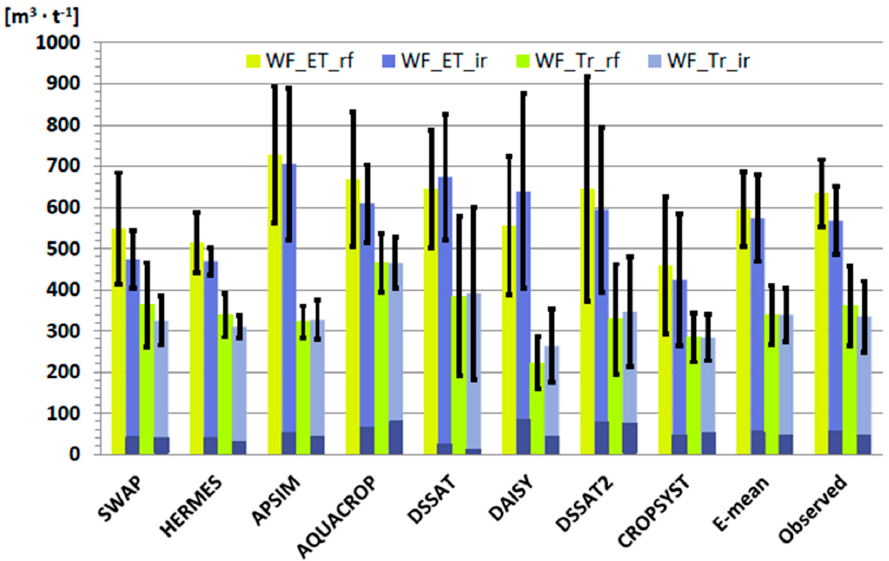
Figure 6. Water footprints of winter wheat calculated from simulations of different models for rainfed (_rf) and irrigated (_ir) variants of the Müncheberg field trial. Calculations were based on ET (WF_ET) and Tr (WF_Tr). Error bars of the model results and observations show inter ‐ annual variability, error bars of the ensemble mean the inter ‐ model variability. “Observed” is calculated from simulated ET and Tr and observed yields. Dark blue columns in WF_ET_ir and Tr_ir show the blue WF based on ET and Tr, respectively.